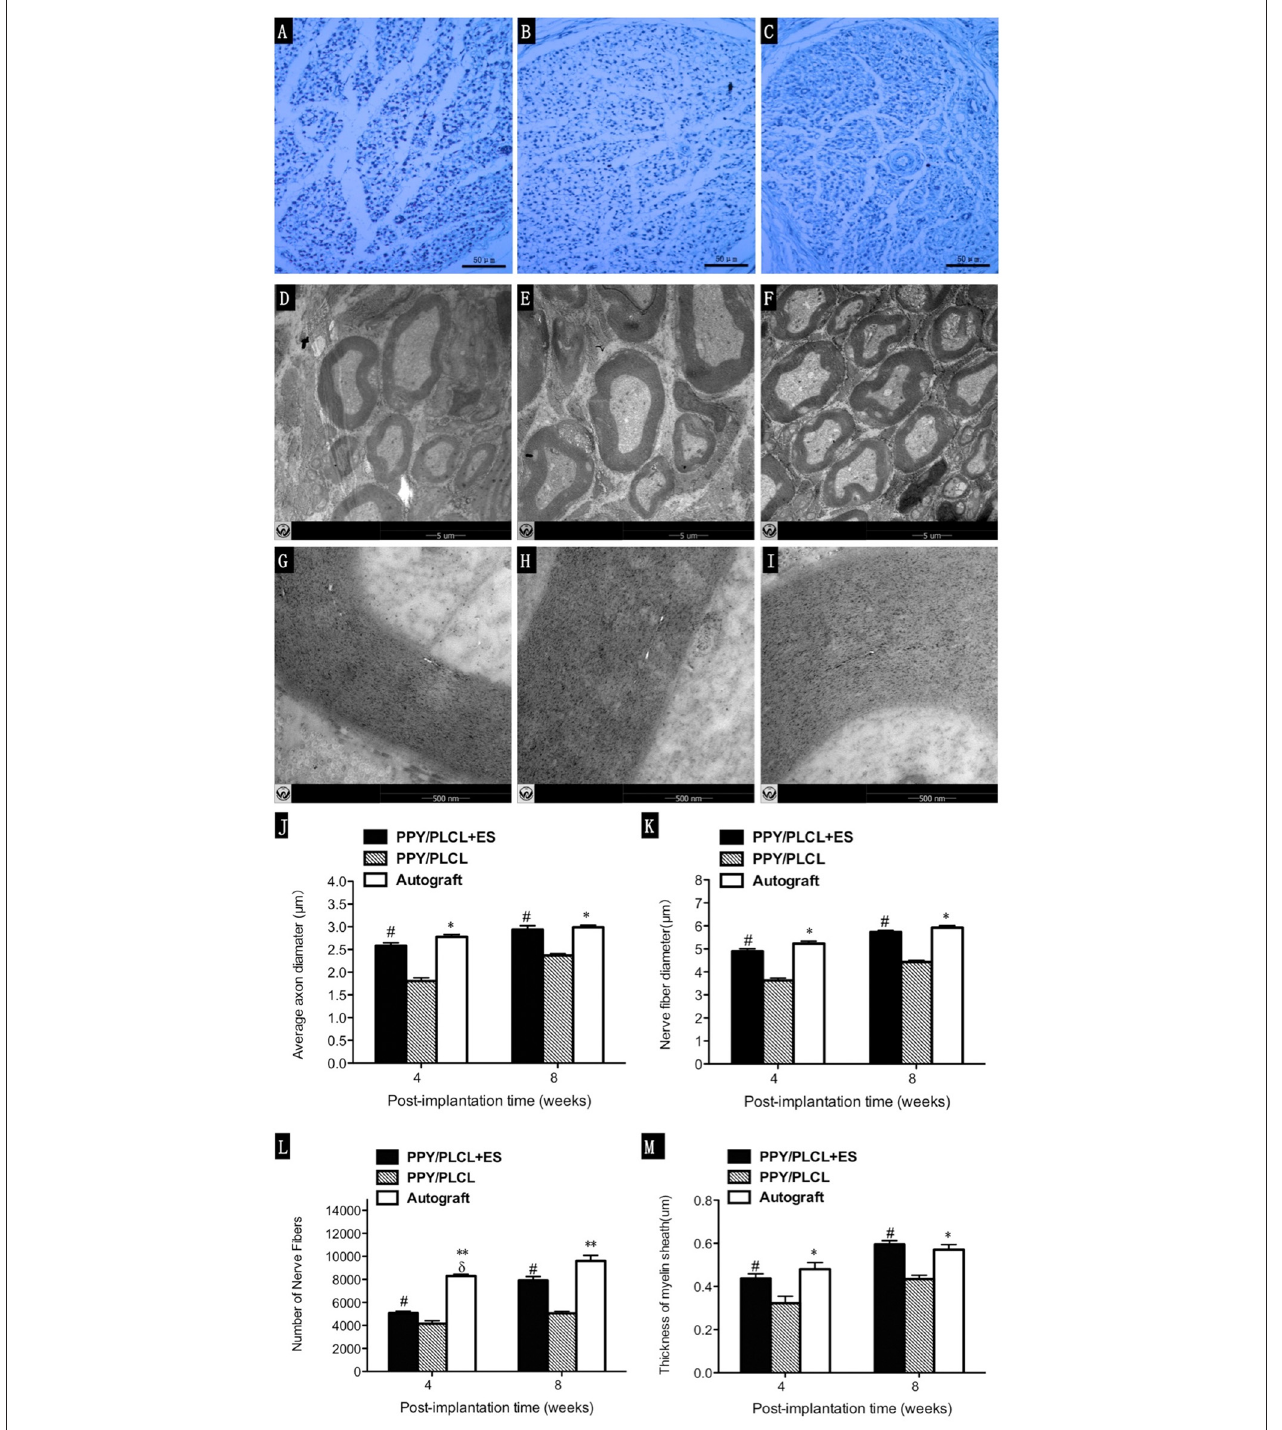
FIGURE 7 | Histology images stained with toluidine blue and transmission electron microscopy (TEM) micrographs. Images represent cross sections of regenerated nerves taken from different conduits in rats at 8 weeks post-implantation. (A,D,G) From the PPY/PLCL group, (B,E,H) from the PPY/PLCL + ES group and (C,F,I) from the autograft group. Histology scale bar: 50 µ m (A–C) . TEM scale bar: 5 µ m (D–F) , 500 nm (G–I) . (J) Average axon diameter. (K) Nerve fiber diameter. (L) Number of nerve fibers. (M) Thickness of myelin sheath ( n = 5, # p < 0.05 the PPY/PLCL + ES group vs. PPY/PLCL group; ∗ p < 0.05, ∗∗ p < 0.01 the autograft group vs. PPY/PLCL group; δ p < 0.05, the autograft group vs. PPY/PLCL + ES group).